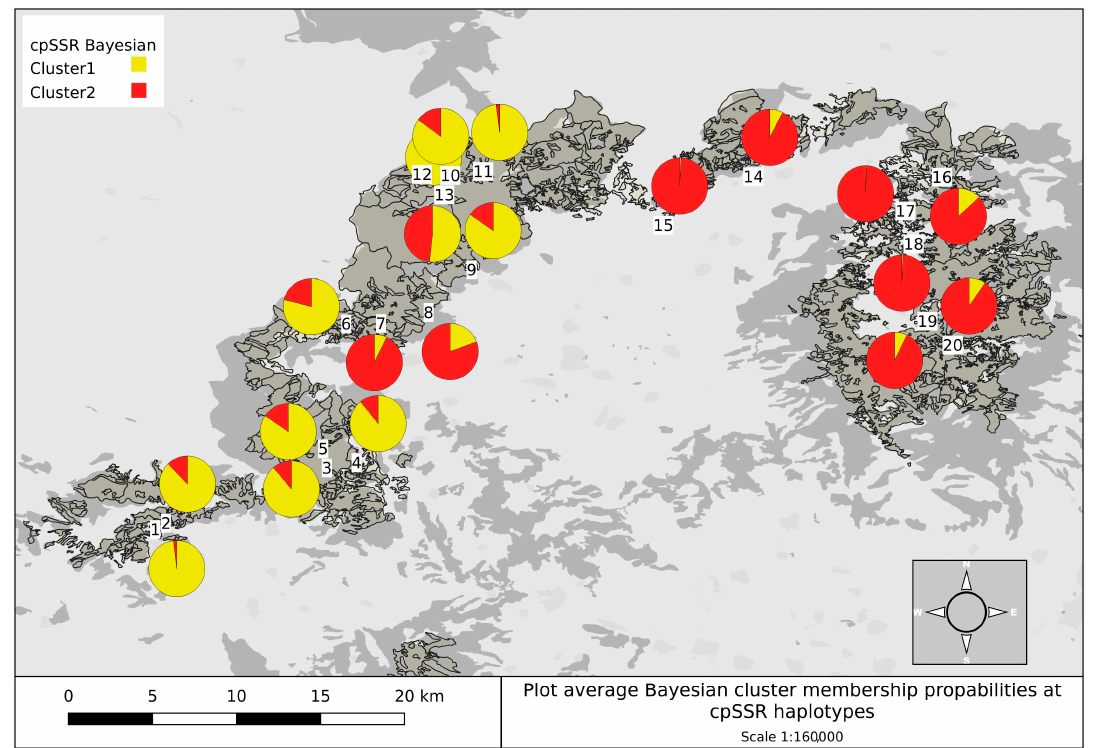
Figure 4. Map of the average Bayesian cluster membership probabilities of the cpSSR beech haplotypes in the 20 plots of the study. Table 3. Measures of genetic diversity at cpSSR and nSSR markers for the 20 plots of the study.